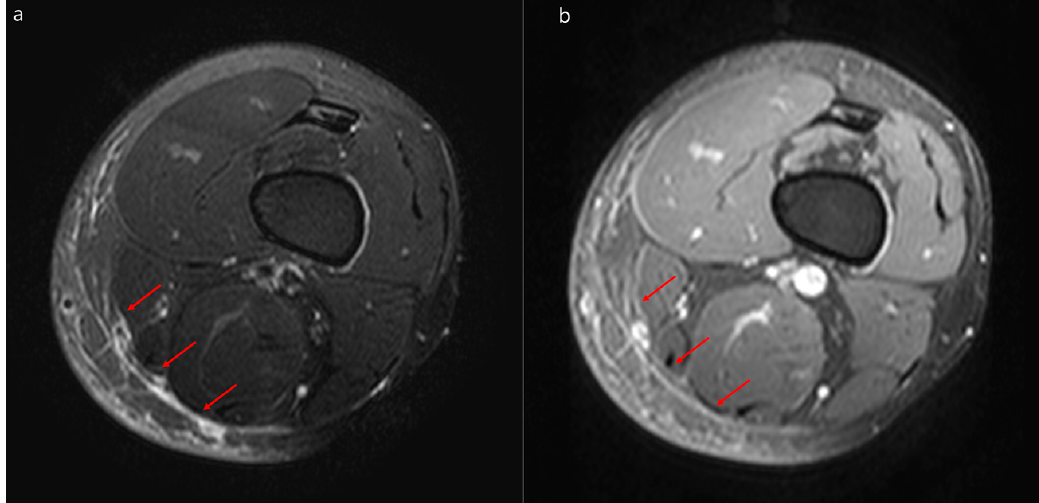
Figure 3. Representative magnetic resonance images of severe cellulitis. Severe cellulitis of the left thigh in a 44-year-old man. ( a ) Fat-suppressed axial T2-weighted magnetic resonance image and a contrast-enhanced magnetic resonance image ( b ) showing localized hyperintensity within the deep peripheral fascia (arrows) with enhancement in the posteromedial thigh.